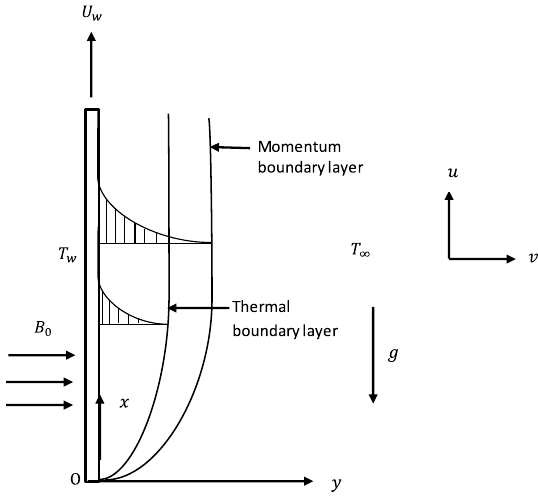
Figure 1: Geometry of the present investigated